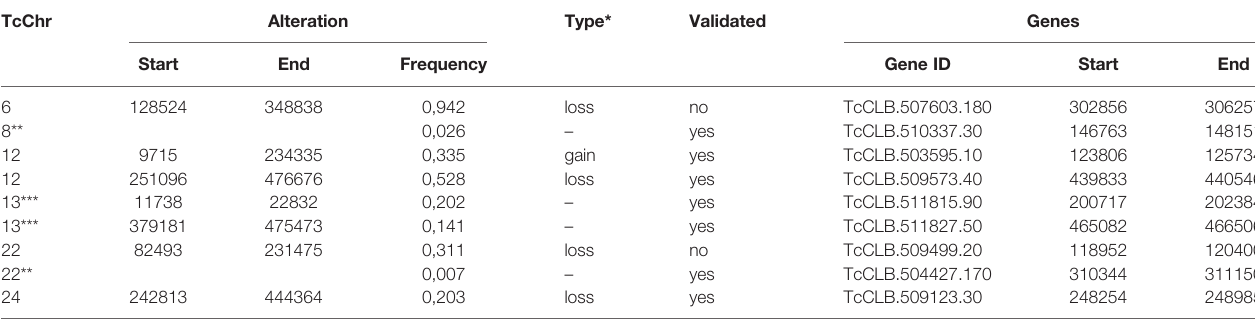
TABLE 1 | Results of quantitative real time PCR analysis for aCGH